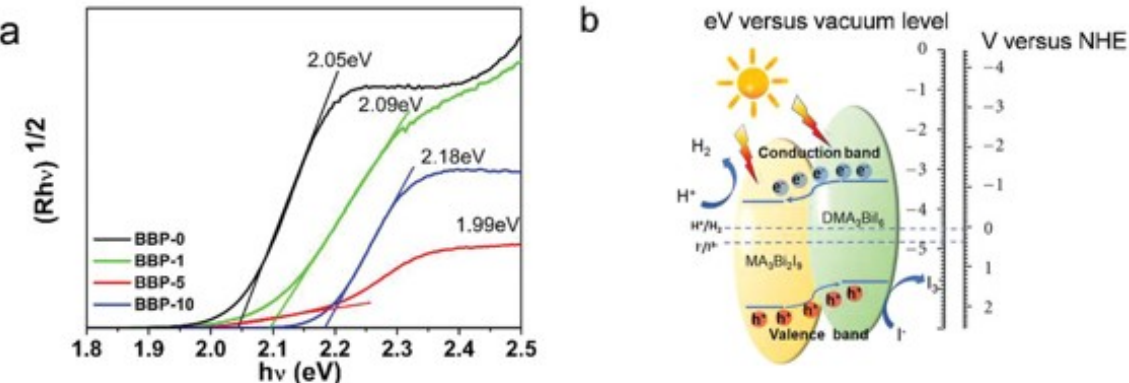
Figure 5. ( a ) Indirect-bandgap Tauc plot for all as-prepared samples. ( b ) Energy level diagram of the BBP-5 with a heterojunction of MA 3 Bi 2 I 9 and DMA 3 BiI 6 for the photocatalytic HI splitting. Reprinted with permission from ref [32]: Copyright 2020, Wiley-VCH GmbH [31].